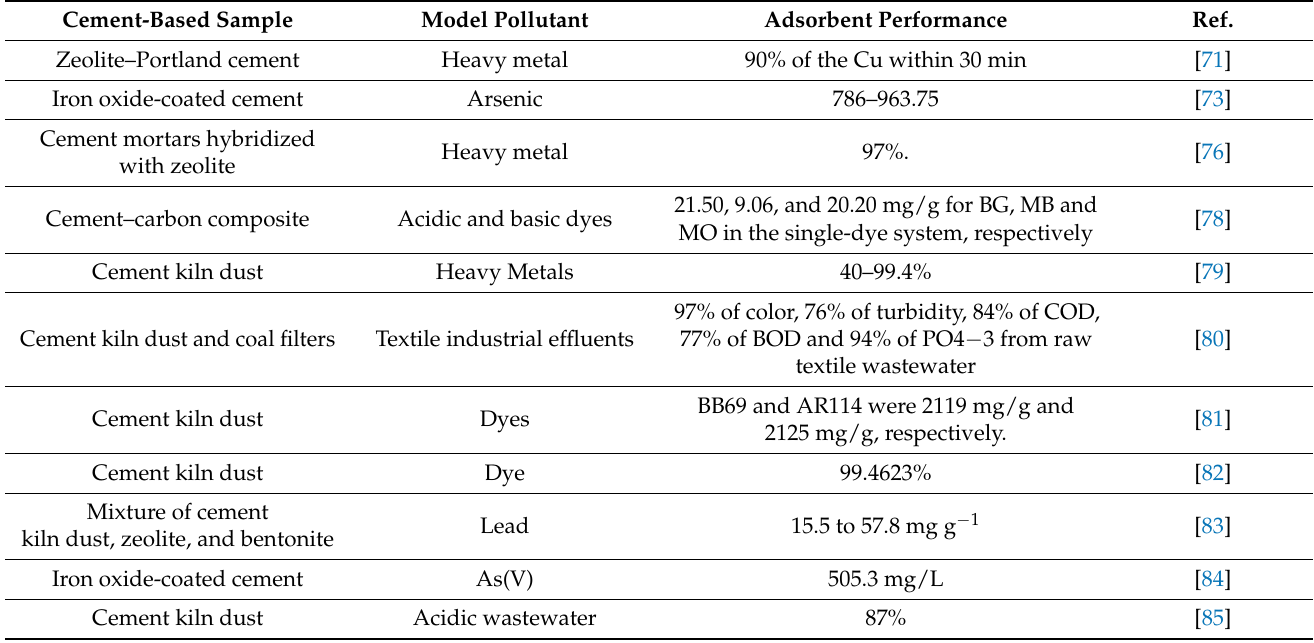
Table 2. Various cement-based composites used as an